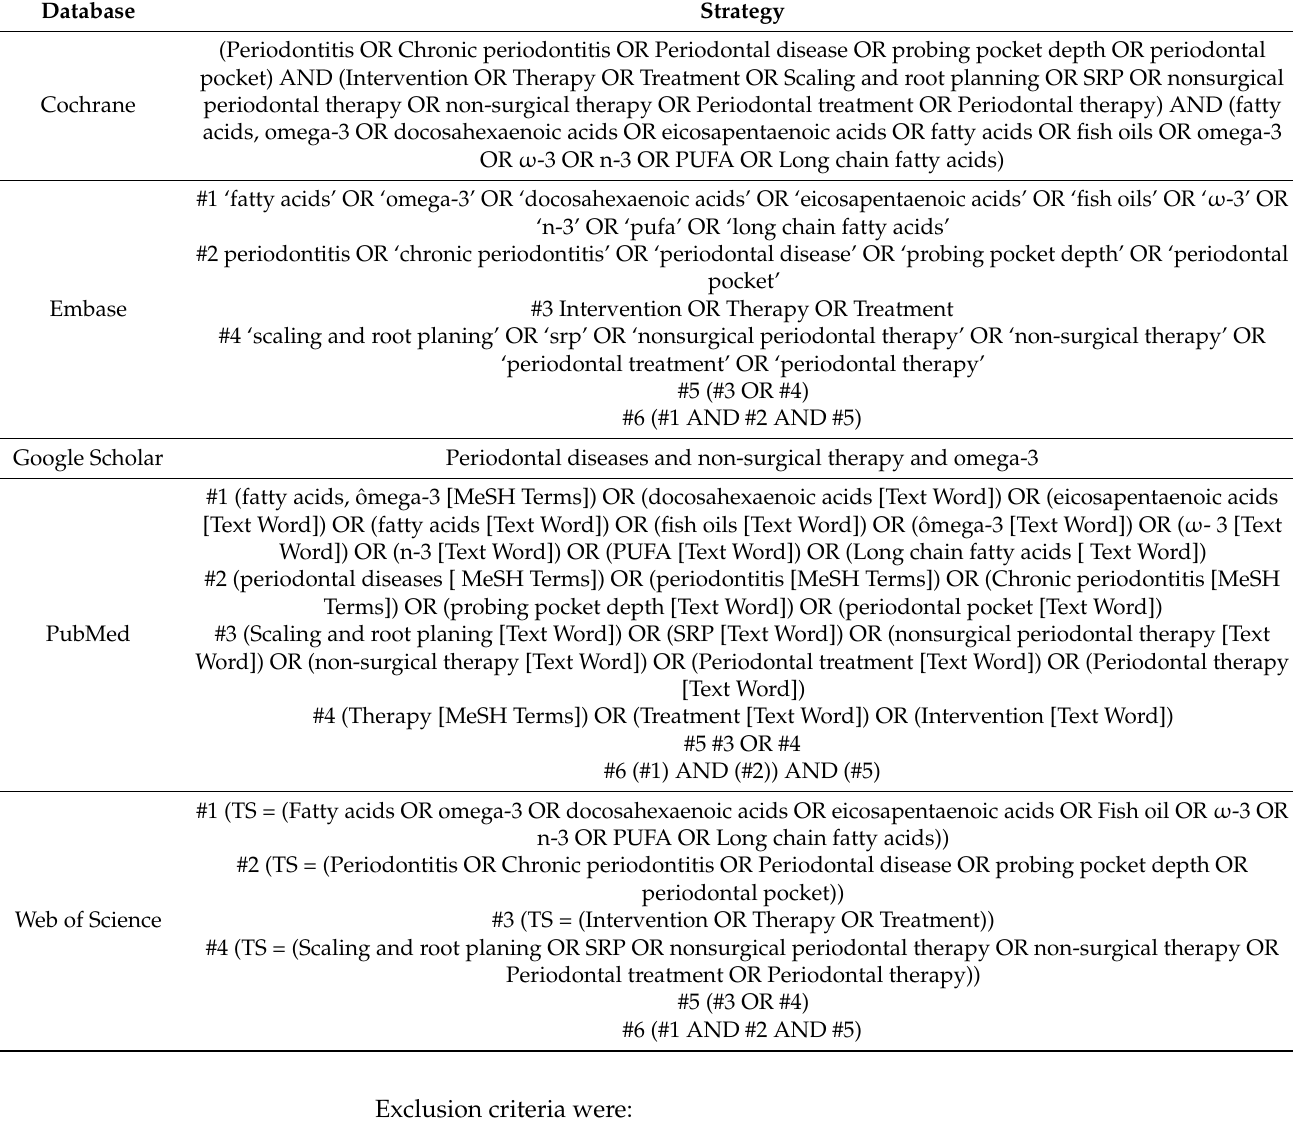
Table 1. Search strategies used to identify studies for inclusion in the systematic review, customized for each